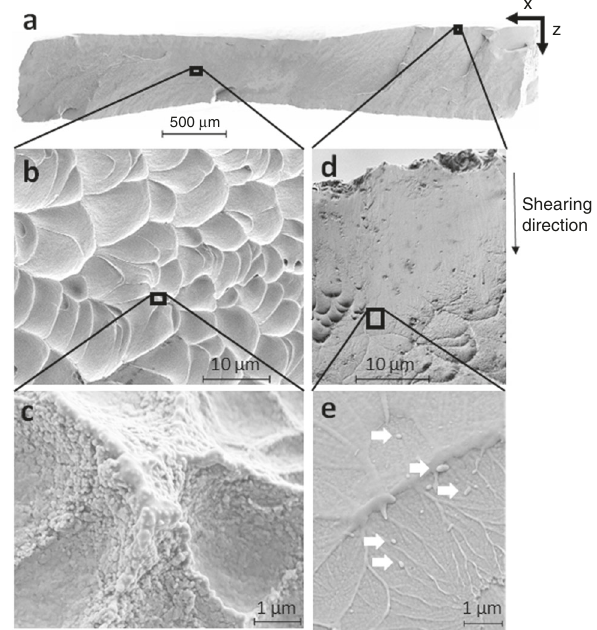
Fig. 4 SEM micrographs of the fracture surface at multiple length-scales. a Projection of the entire fracture surface in the section of the tensile specimen. b Representative fl at shaped dimples covering most of the fracture surface. c Magni fi ed view of a dimple wall. The cap of the wall appears as molten and resolidi fi ed. d Overview of the stretched surface sheared along the z axis, covering one side of the fracture surface along the x axis. e Magni fi ed view of the transition between the stretched surface and the dimples. The observed pattern looks like a Taylor meniscus pattern, which only forms in viscous materials. The white arrows indicate the presence of resolidi fi ed